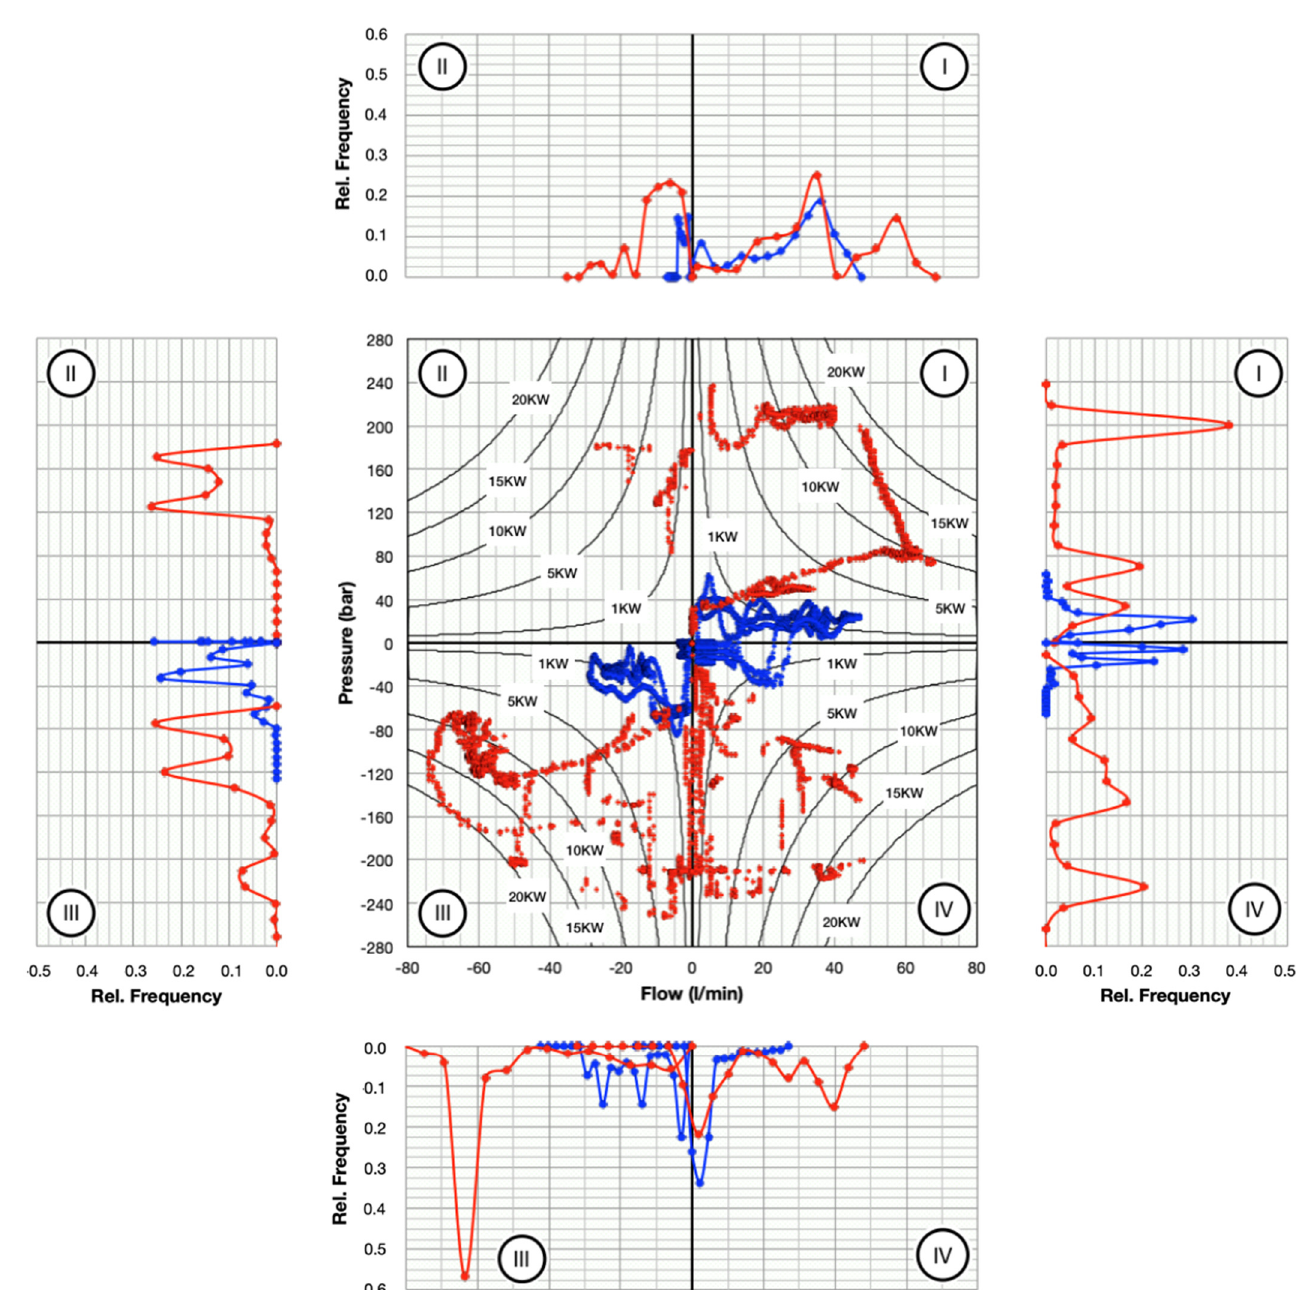
Figure 20. Complete quadrant analysis for the extension actuator.